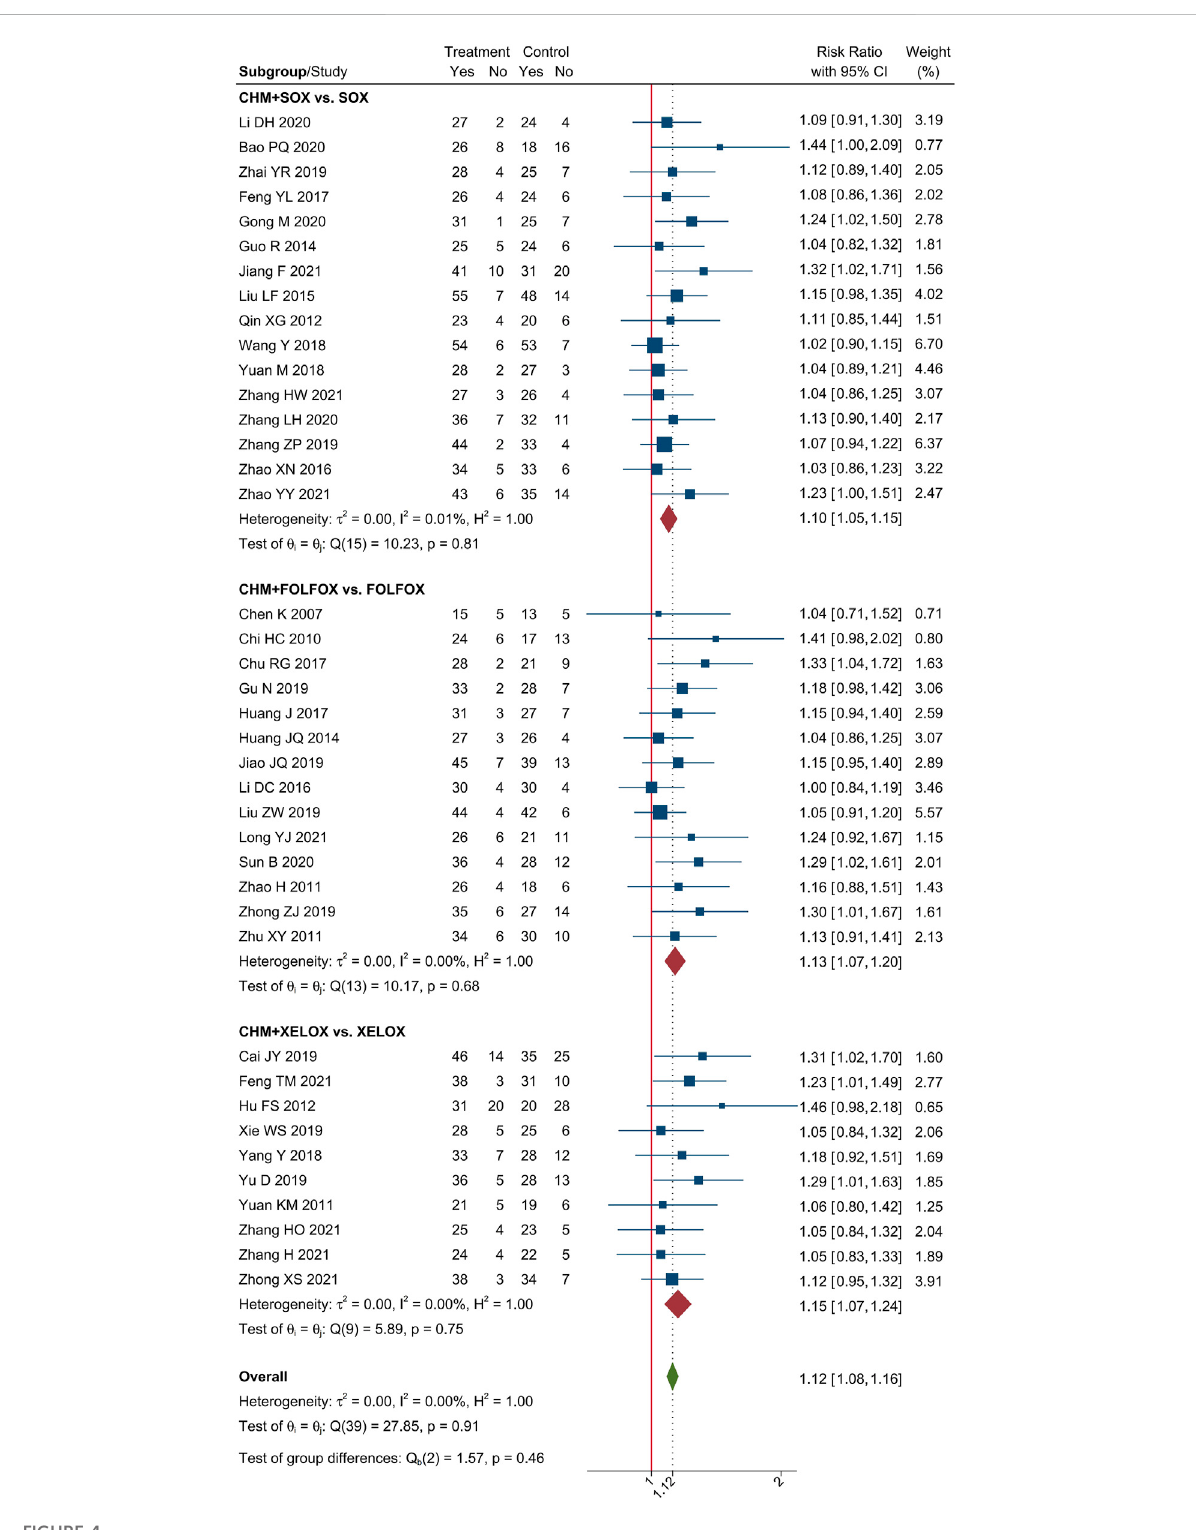
FIGURE 4 Forest plot of